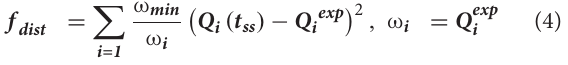
Frontiers in Physiology |